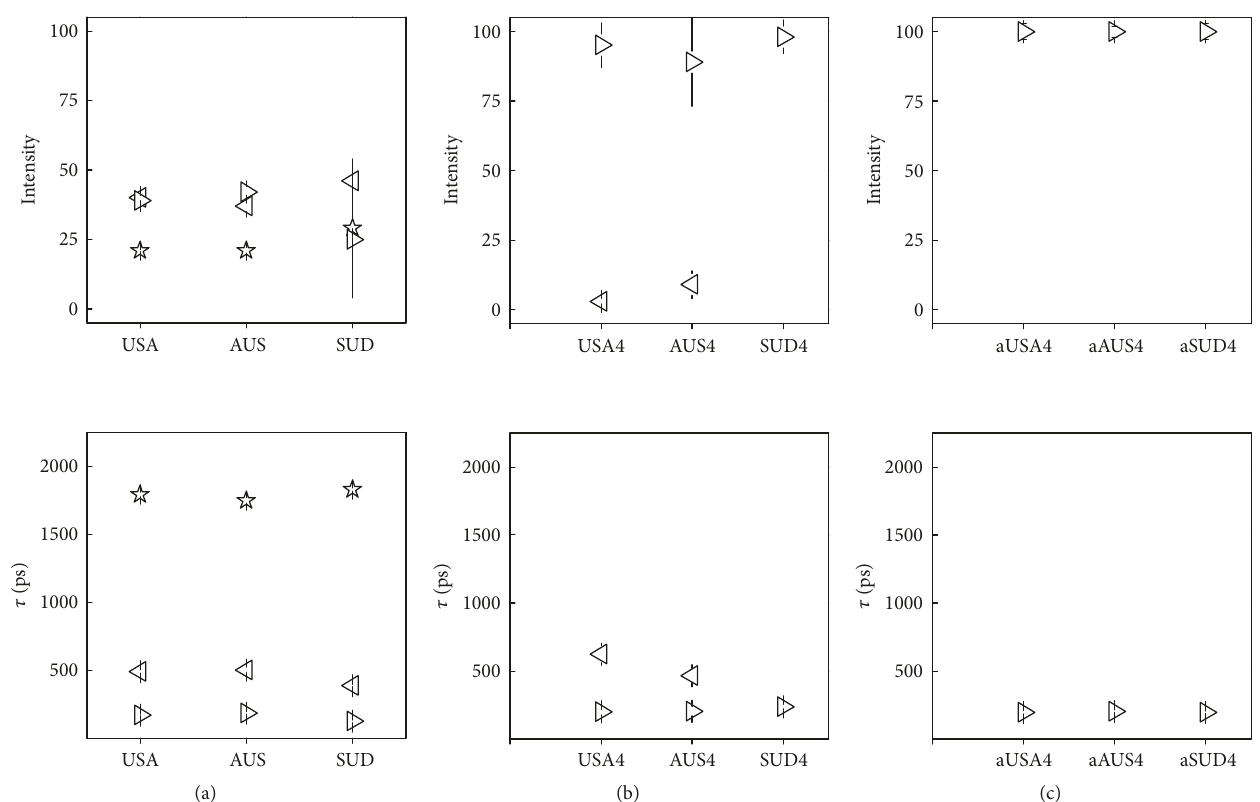
Figure 2: Lifetime components and their intensities determined by PALS for the natural (a), the micronized (b), and the annealed micronized sands